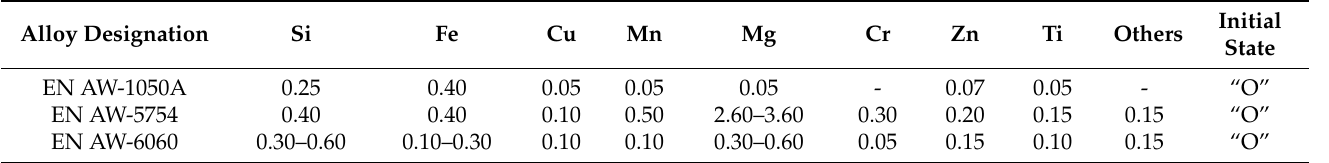
Table 1. Chemical composition (standard limit of the composition) of aluminum alloys applied in measurements—percentage of alloying elements [38].